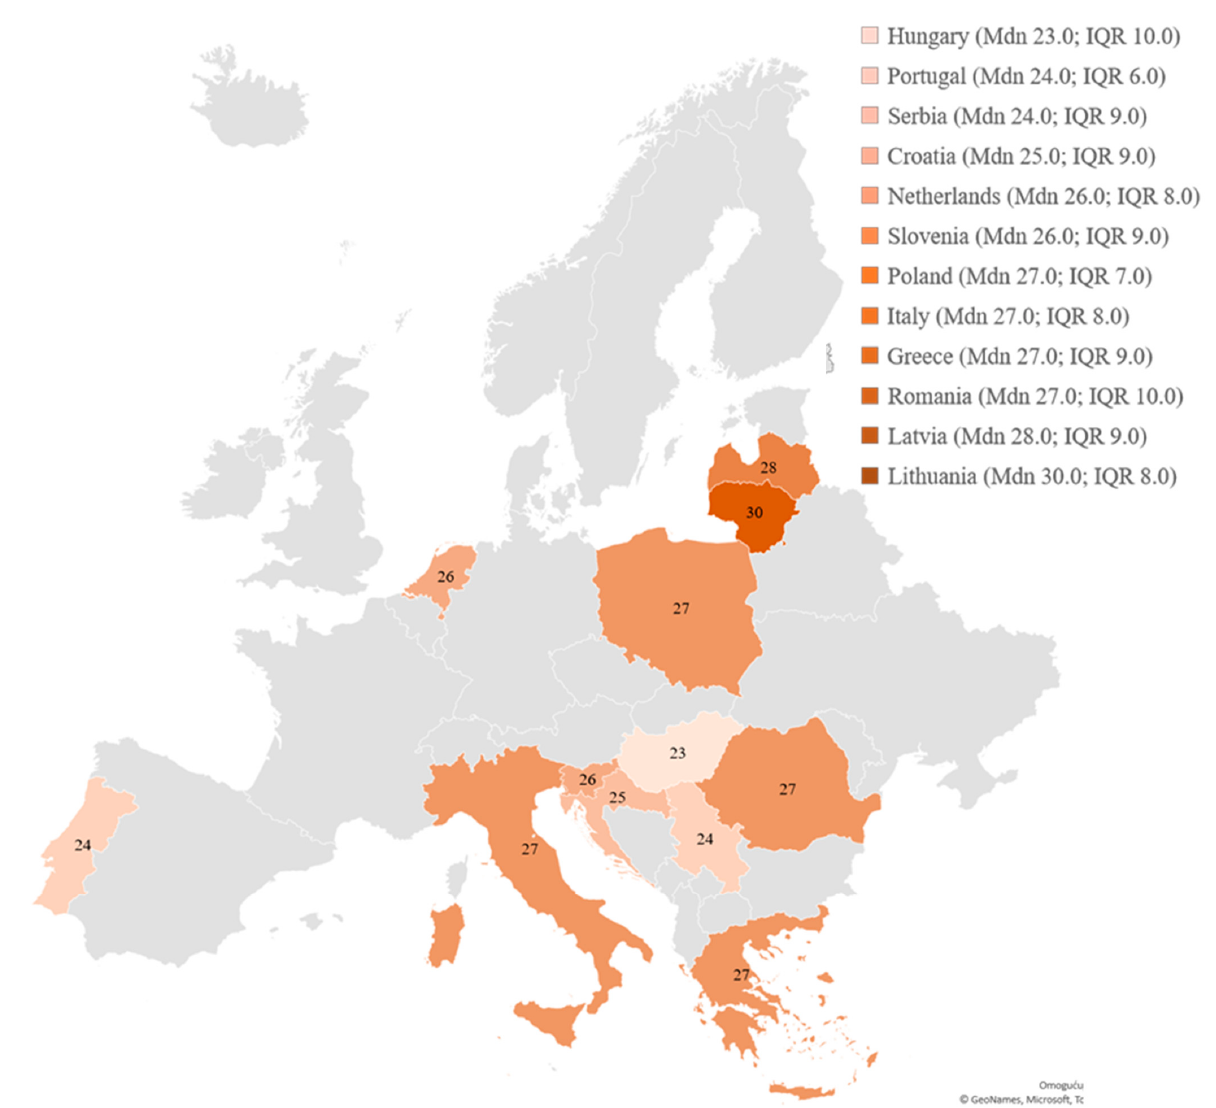
Figure 1. Overall emotional eating behavior among the European countries by median values (ranging from 9 to 45); Countries’ colors ranged from lighter to darker; lighter colors indicated a lower frequency, and darker ones a greater frequency of food consumption in various emotional conditions.